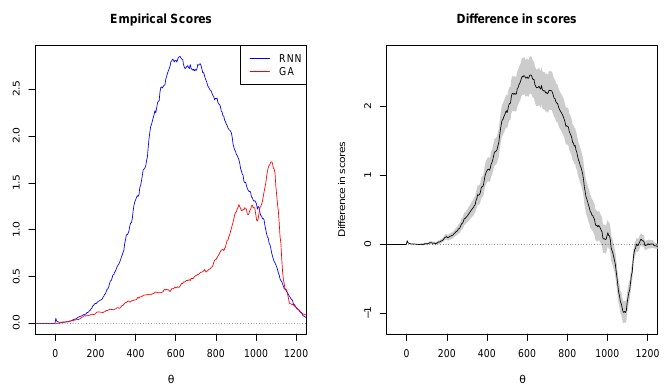
Figure 7. Plots of the RNN and GA forecasts showing the relationship between their empirical scores ( left panel ) and the differences in empirical scores with 95% confidence intervals ( right panel